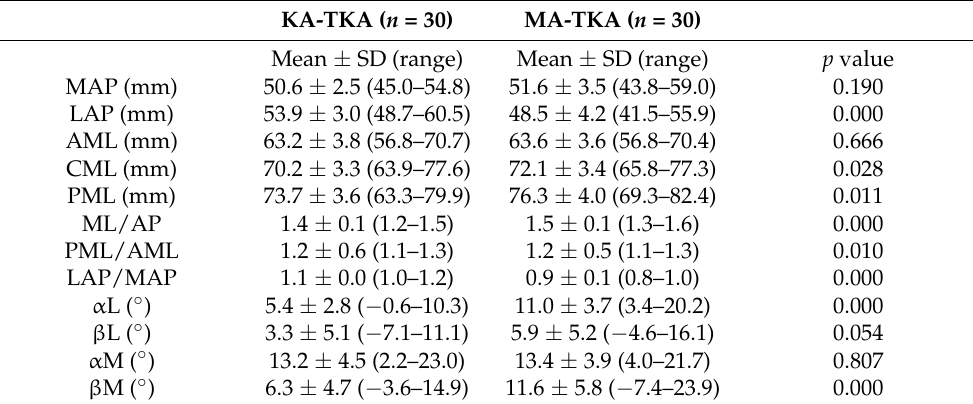
Table 3. Comparison of male distal femoral dimensions by two types of surgery.